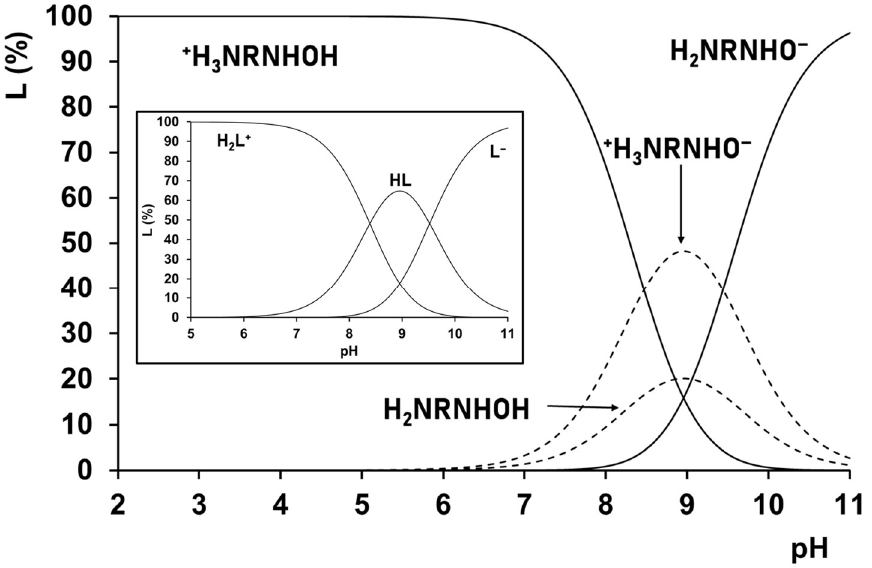
Figure 2. Concentration distribution curves of the proton complexes of H 2 - β -Alaha + , calculated using the dissociation macro constants (inlet) and micro constants as a function of pH. Dash lines refer to the corresponding binding isomers of HL.